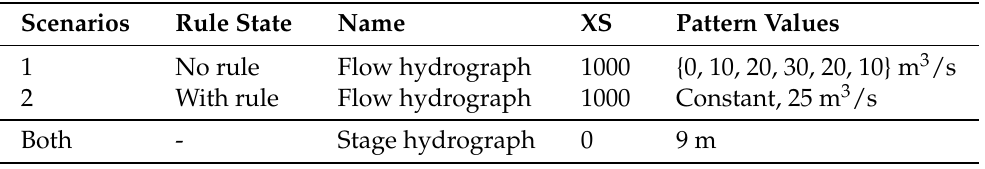
Algorithm 1 Control rule for the rectangular canal if WSE at XS 700 is higher than 9.3